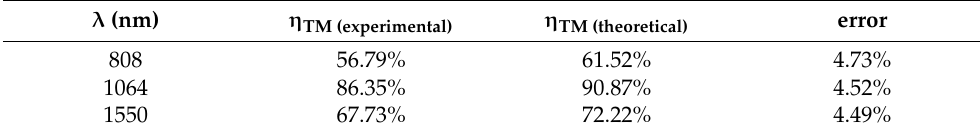
Table 1. The measured results of the diffraction efficiency at +1 diffraction